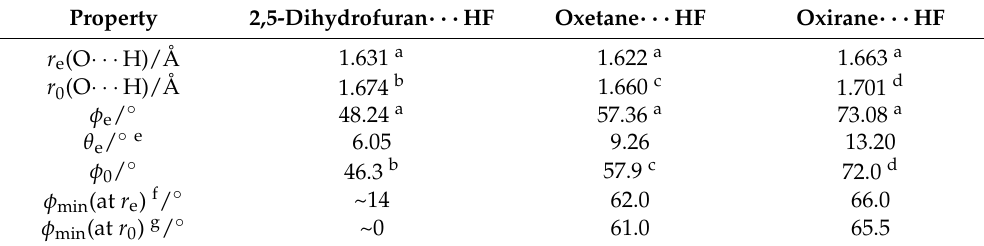
Table 1. Comparison of properties of cyclic ether ⋯ HF complexes from ab initio calculations, from rotational spectroscopy, and from an electrostatic model in which HF is treated as an extended electric dipole (see text for discussion of how V HF ( φ ) is calculated by using a DMA of the cyclic ether charge distribution in this case).